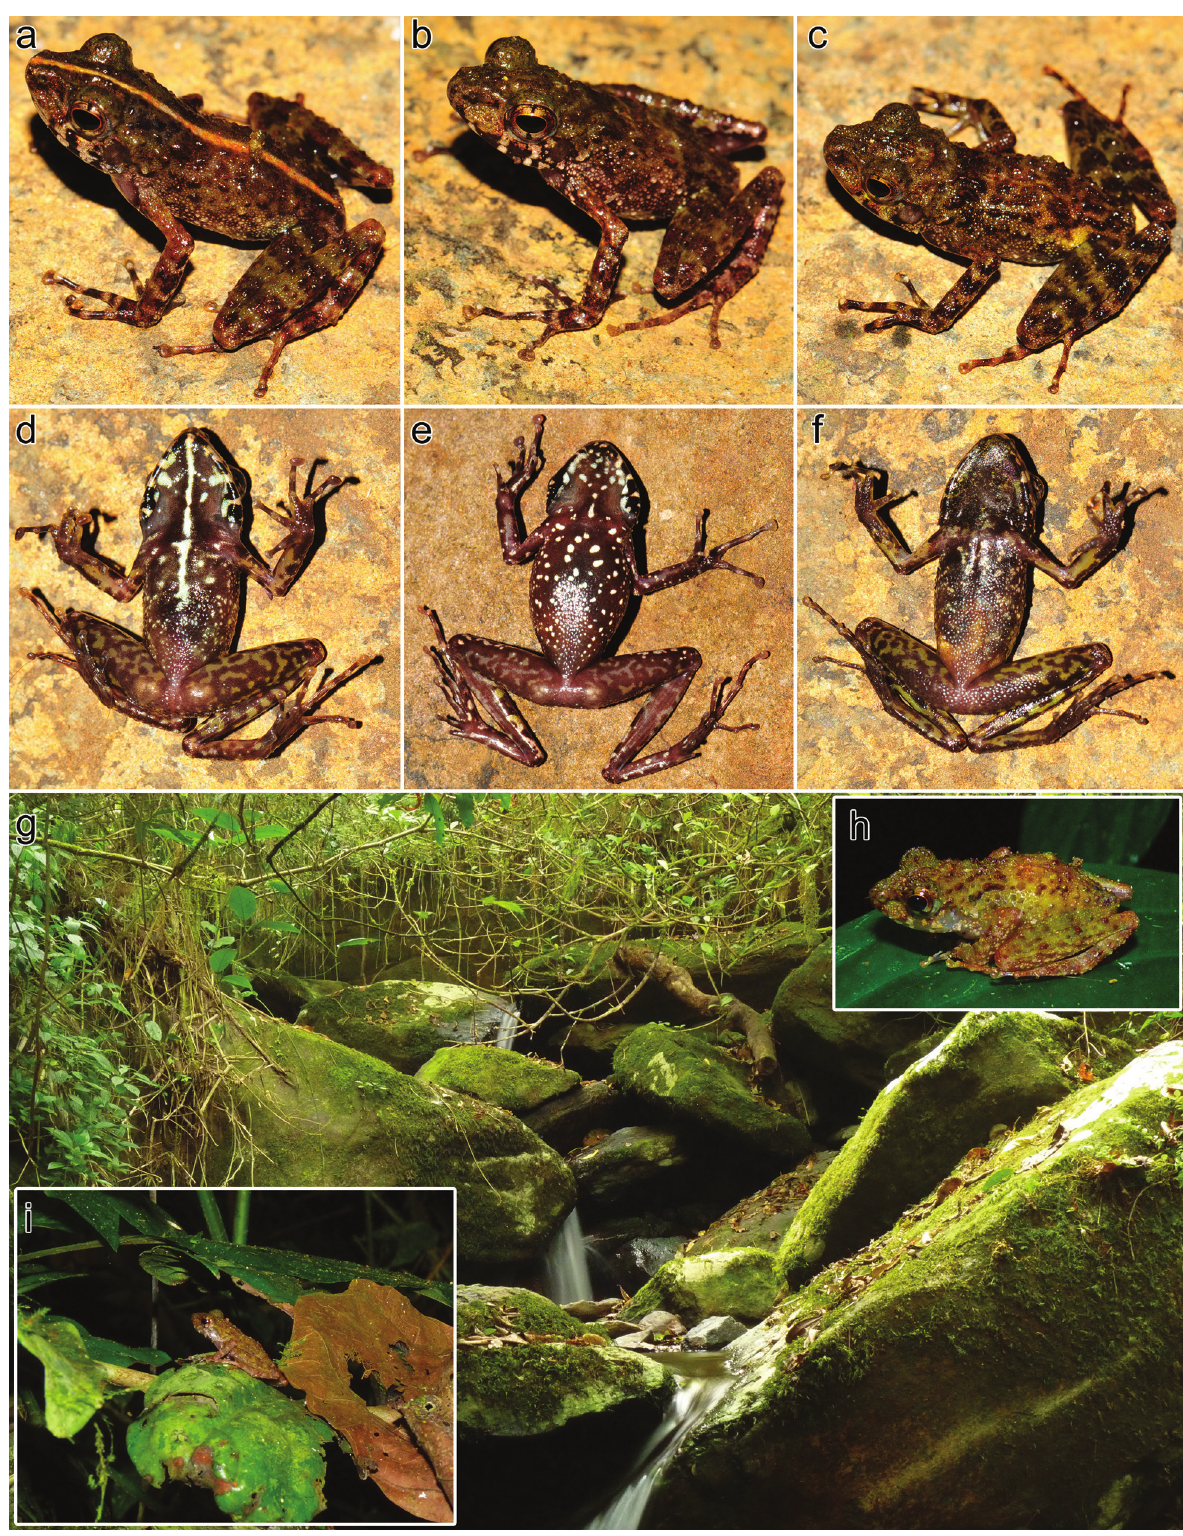
Figure 4. Photographs of Gephyromantis ( Vatomantis ) lomorina sp. n. and its habitat in Sorata. (a,d) ZSM 1545/2012; (b,e) ZSM 1547/2012; and (c,f) ZSM 1549/2012, not to scale; (g) habitat where several specimens were found in Sorata, showing (h,i) the appearance of the species in situ whilst calling at